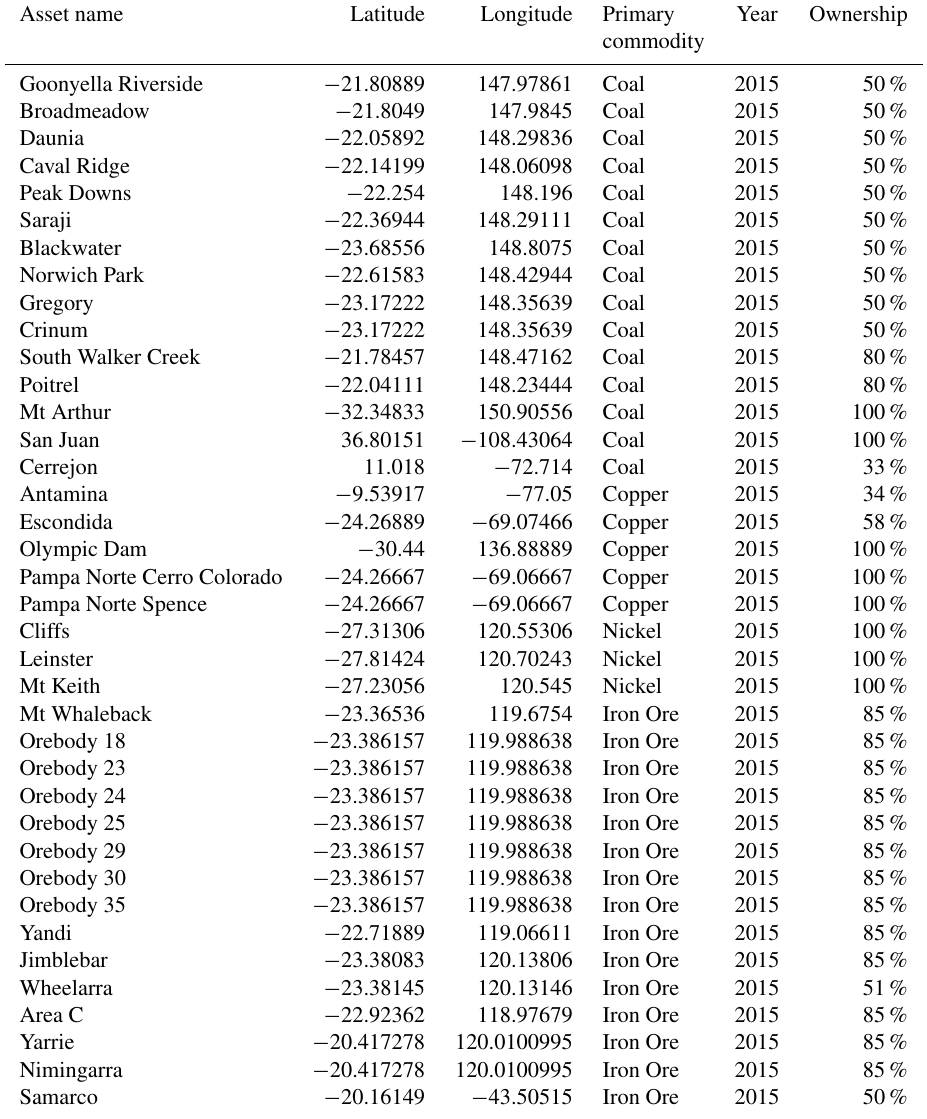
Table A1. 2015 mining asset coordinates for BHP